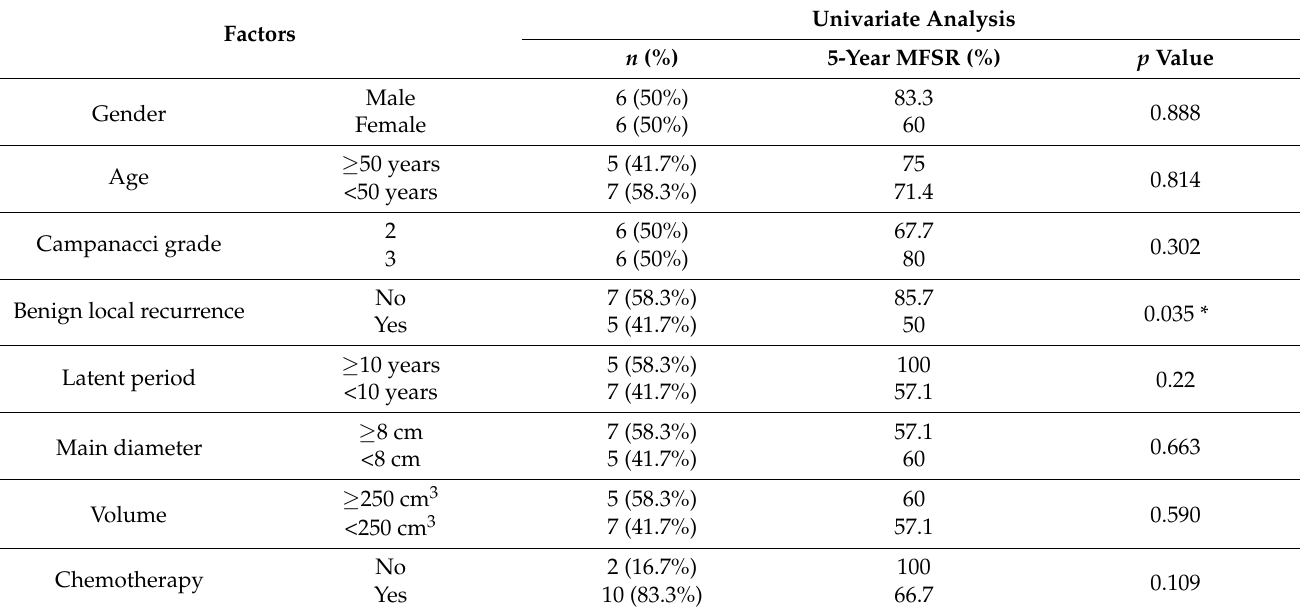
Table 5. Statistical analysis of prognostic factors for distant metastasis-free survival.